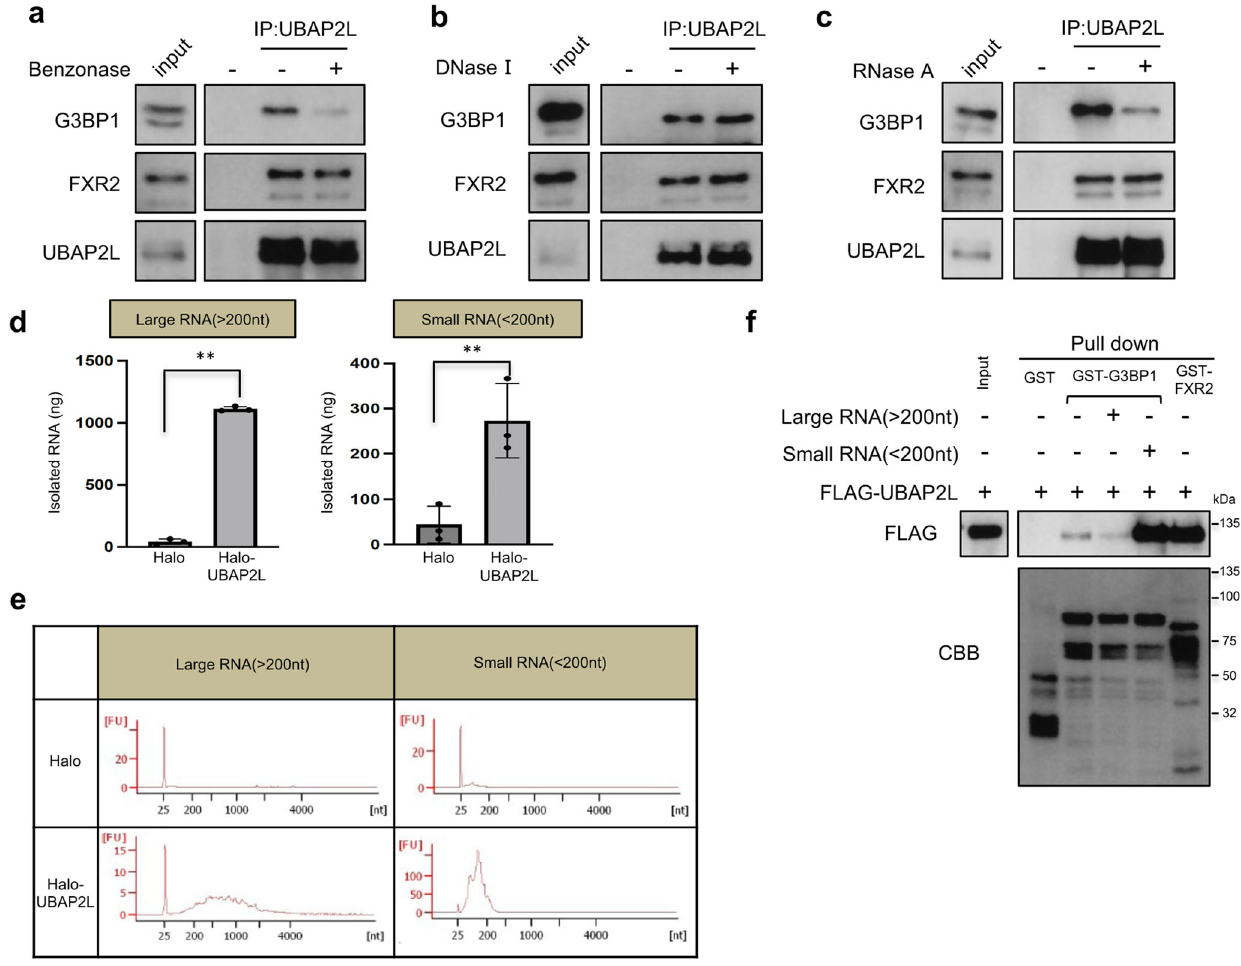
Fig. 4 Small RNAs are required for the interaction between UBAP2L and G3BP1. a UBAP2L was immunoprecipitated with an anti-UBAP2L antibody from HeLa cell lysates. The immunoprecipitates were treated with Benzonase and immunoblotted with anti-UBAP2L, anti-G3BP1, and anti-FXR2 antibodies. b , c HeLa cells were lysed and immunoprecipitated as in a . The immunoprecipitates were treated with DNase 1 or RNase A and immunoblotted with the indicated antibodies. d 293T cells that constitutively expressed the Halo tag or Halo-UBAP2L were immunoprecipitated with an anti-Halo antibody. Large RNAs (>200 nt) or small RNAs (<200 nt) were isolated from the immunoprecipitates. The graphs show the amounts of isolated RNAs (ng). Three independent experiments were performed (** P < 0.01). e The Bioanalyzer quality analysis of each isolated RNA is presented in the graphs. f Immunoprecipitaed FLAG-UBAP2L was mixed with recombinant GST, GST-G3BP1, or GST-FXR2 bound to glutathione beads with or without larges RNAs (20 μ g) or small RNAs (8 μ g). The beads were precipitated and subjected to immunoblot analysis with an anti-FLAG antibody. CBB indicates Coomassie brilliant blue staining of